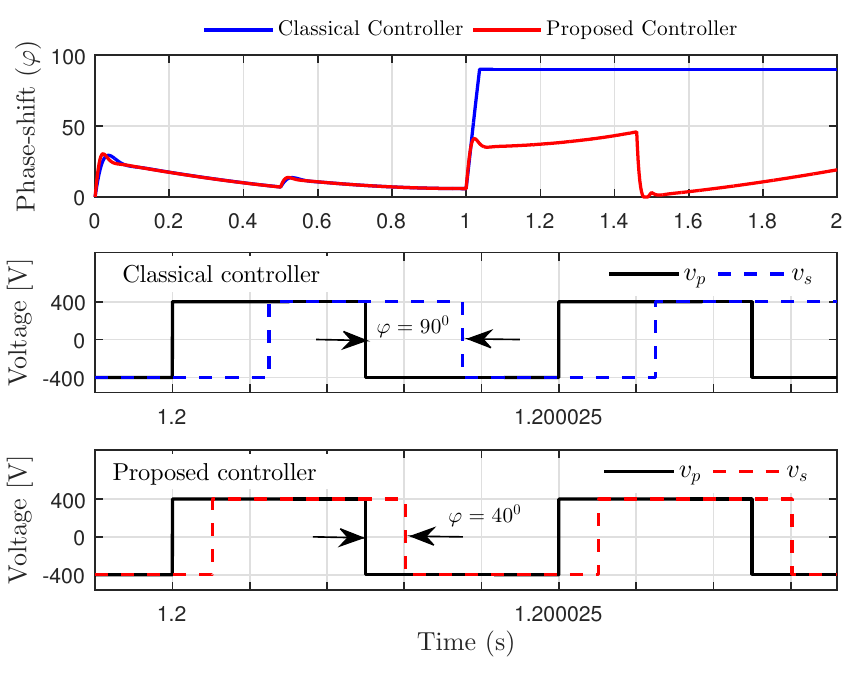
Figure 13. Simulated Case III: ( a ) dc–bus voltage; ( b ) microgrid power flow time–domain for classical and proposed controller; and, ( c ) phase–shift control and Pulse voltage of two Full–Bridges, v p and v s